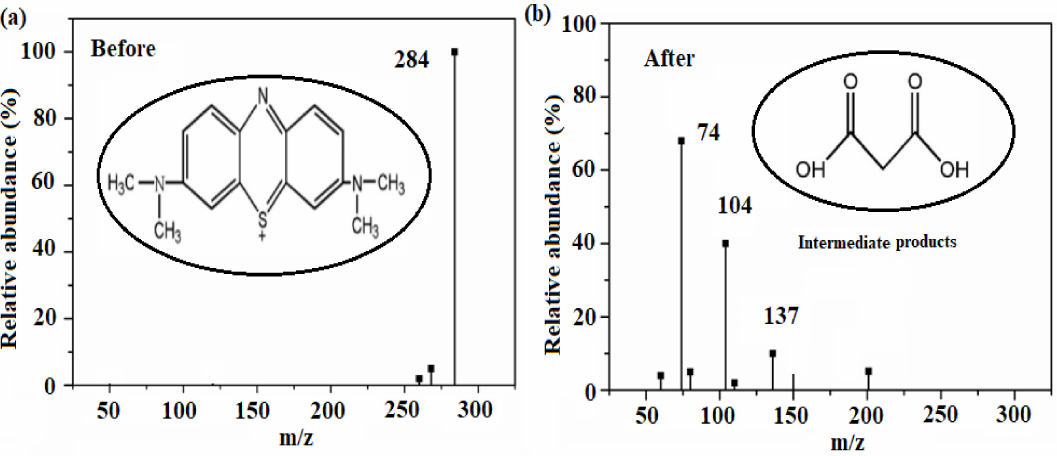
Figure 8. ESI-MS analysis of MB dye degradation ( a ) before and ( b ) after intermediate products. Noticeably, after 90 min of photodegradation, the constituents have gone; the prelimi- nary step of the MB degradation would attack the *OH radicals that adapt the C–S + =C and C=N–C bonds to the C–SH (=O) 2 –C and C–NH–C. The dye degradation intermediate prod- ucts obtained at ( m / z ) 202, 137, 110, 104 and 74 were detected. Since the visual